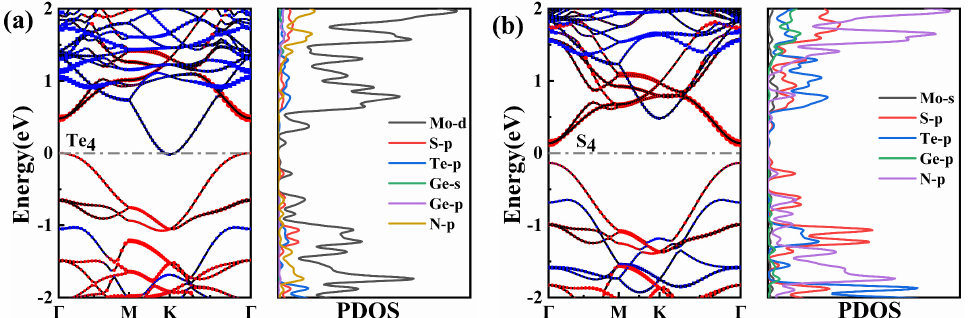
Figure 2. The weighted band structures and PDOS of ( a ) Te 4 –MoSTe/MoGe 2 N 4 vdWH and ( b ) S 4 –MoSTe/MoGe 2 N 4 vdWH. The Fermi levels are set to zero. Red represents the weights by Janus MoSTe; blue indicates weights by MoGe 2 N 4 .